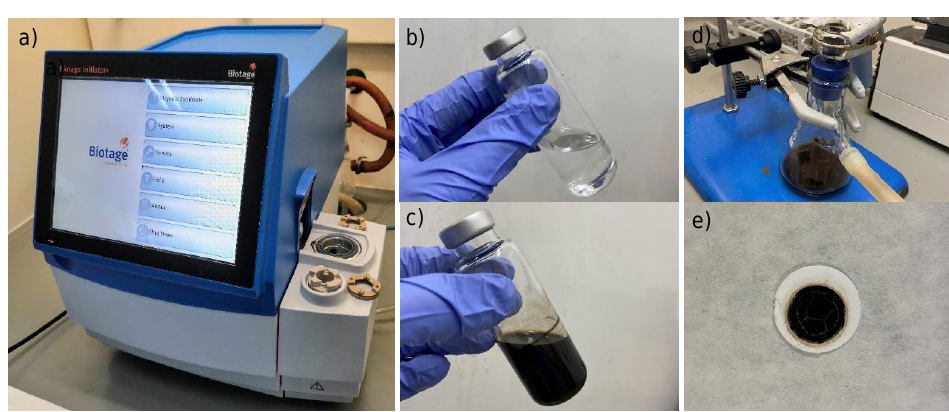
Figure 1. ( a ) Microwave reactor using in the present work; ( b ) equimolar water solution of NaCN and NH 4 Cl; ( c ) raw reaction. A representative suspension of the cyanide polymers; ( d ) filtration sys-tem. In the bottom part, dark solution or sol fraction which will be freeze-dried. In the upper part, black insoluble solid or gel fraction; ( e ) characteristic cyanide polymer over a glass fiber filter after drying by reduced pressure. Table 1. Experimental conditions used for the synthesis of NH 4 CN polymers assisted by MW radi- ation, as well as some of their properties. Note that polymer 2 is present in both series. 1 Maximum pressure reached along the syntheses. * No reproducible measurements.